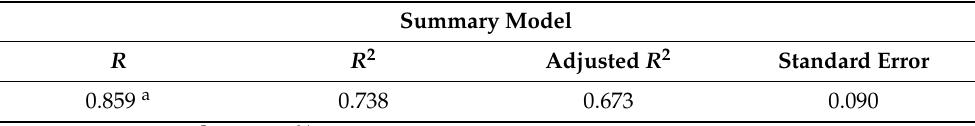
Table 10. Determination coefficients for strain model of CDWRCon.